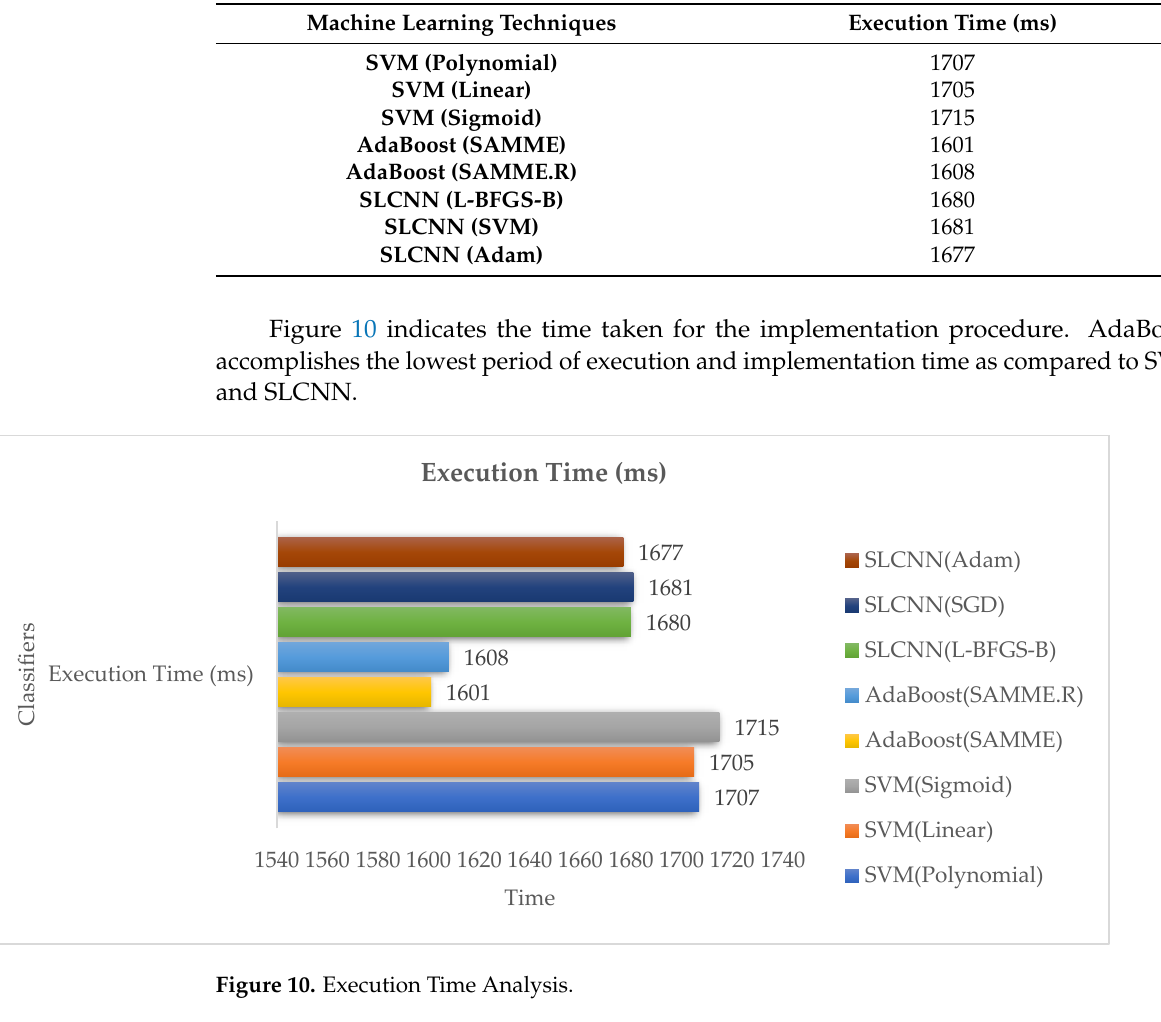
Figure 11. Model Comparison by Performance Measures during Testing.